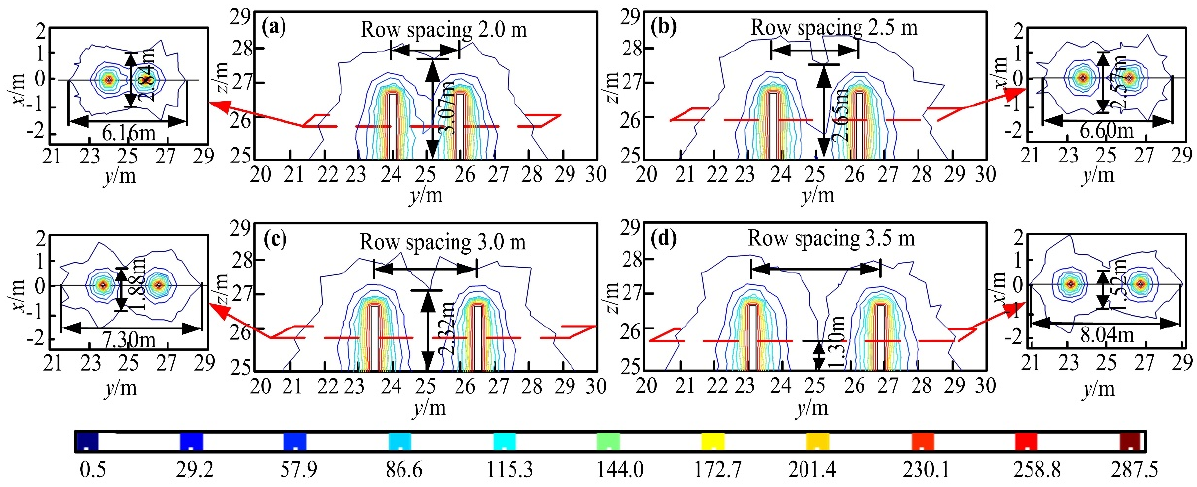
Figure 10. Grouting bolt layout and grout diffusion effect in horizontal and vertical longitudinal section (i.e., xy plane and yz plane) of roadway. ( a ) Row spacing of 2.0 m; ( b ) row spacing of 2.5 m; ( c ) row spacing of 3.0 m; ( d ) row spacing of 3.5 m.